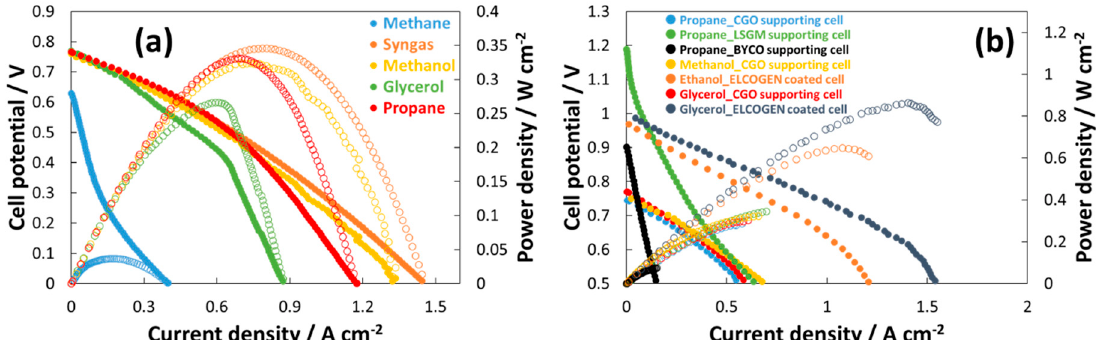
Figure 4. Polarization curves for the modified perovskite-based cells operating in multifuel mode in the presence of a thick supported CGO electrolyte ( a ) adapted from [59] and with different organic fuels and cell designs ( b ) adapted from [56–58,61–63]. (Standard deviation was < 5 mV for each data point of the overall polarization dataset).